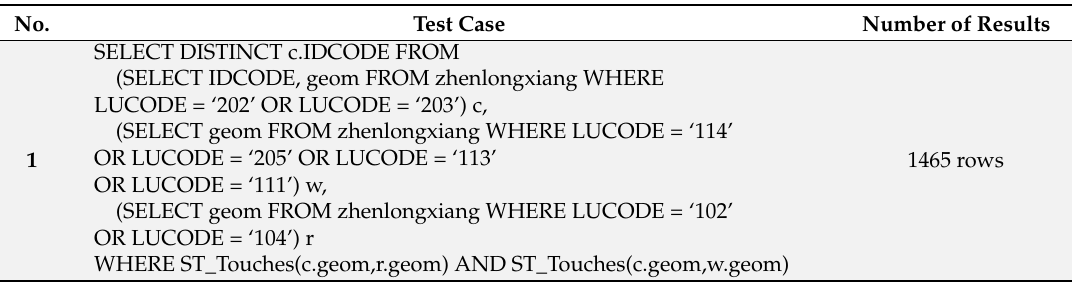
Table 18. Test cases of spatial join queries.